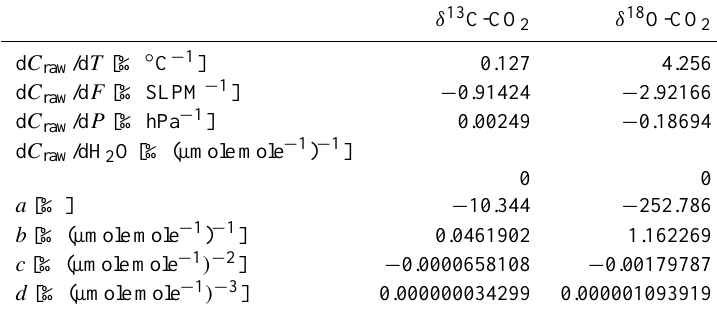
Table 1. Interspecies interference and cross-sensitivity correction factors for δ 13 C-CO 2 and δ 18 O-CO 2 used in Eqs. (2) and (3). Refer- ence values were T ref = 31.8 ◦ C, F ref = 1.0SLPM, P ref =1100hPa and H 2 O ref = 0µmolemole − 1 , for temperature, flow, pressure and water vapour content,